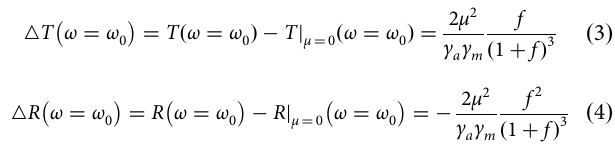
Fig. 2a. The coupling ef fi ciency is related to the near fi eld intensity and the overlapping of molecules to the antenna near fi